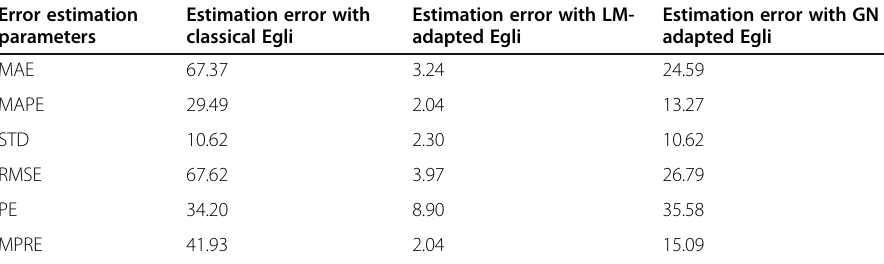
Table 5 Computed first order estimates statistics for Cell_3 Error estimation parameters